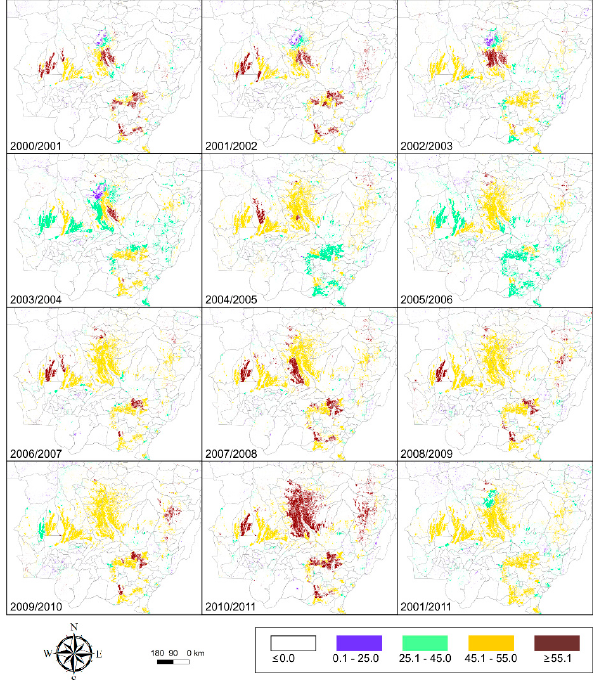
Figure 11. Gaussian areal kriging prediction of the soybean crop yield (total number of 60-kg bags per ha − 1 ) inside the soybean-harvested areas that were detected by remote sensing, per harvest period (2000/2001 to 2010/2011) and the averaged years (2001/2011).